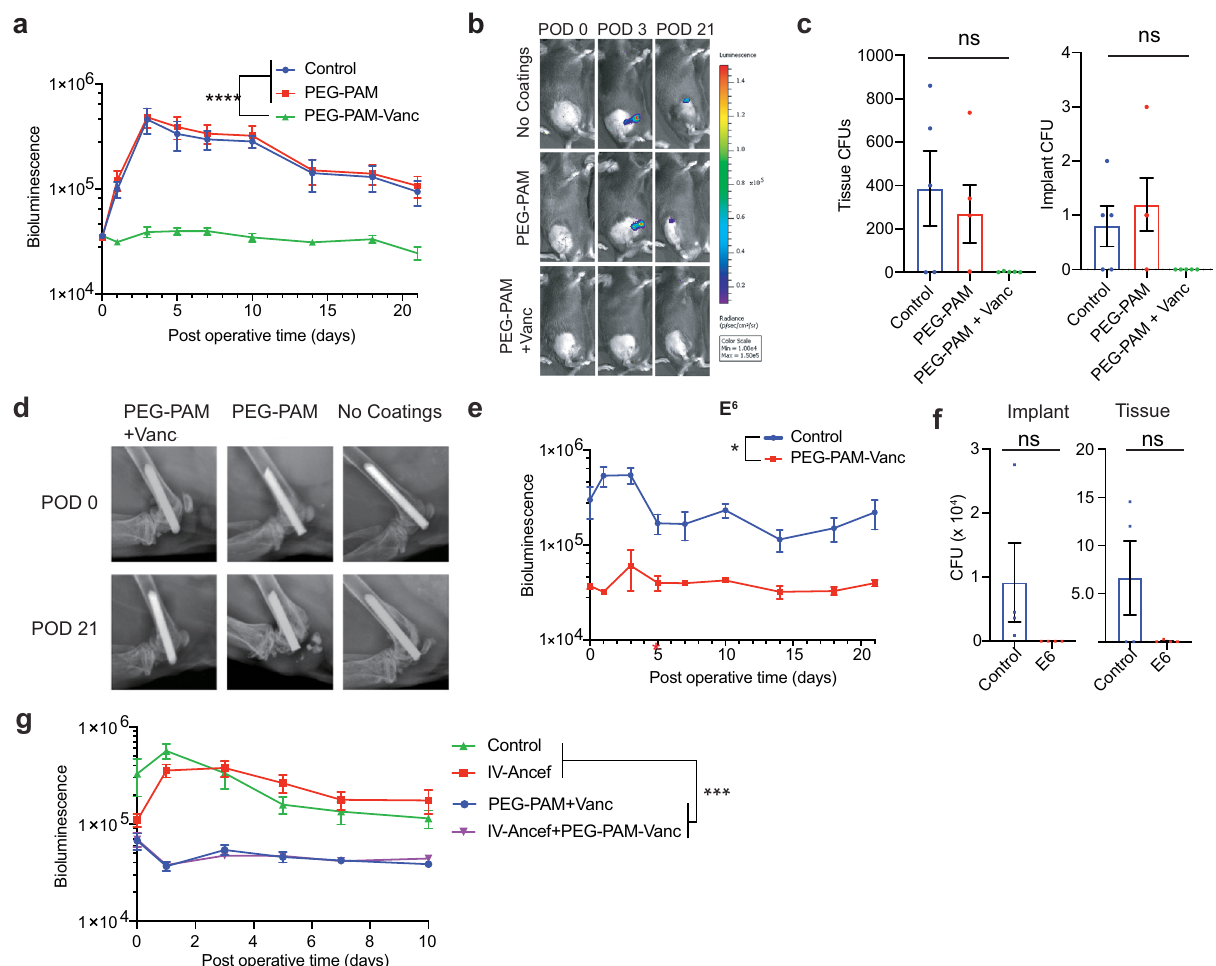
Fig. 5 PEG-PAM coatings loaded with vancomycin prevent implant infection. a Postoperative in vivo S. aureus bioluminescence signal (mean maximum fl ux [photons/sec/cm 2 /sr] (logarithmic scale, n = 15 for no coatings group, n = 14 for PEG-PAM only group, n = 14 for PEG-PAM-Vanc group). b Representative in vivo S. aureus bioluminescence on a color scale overlaid on grayscale images of mice ( c ) Quanti fi cation of colony-forming units (CFUs) cultured from surrounding tissue and implant ( n = 5 for no coating group, PEG-PAM group, and PEG-PAM + Vanc group). d Representative radiographs from the no coatings, PEG-PAM, PEG-PAM + Vanc groups of POD 0 and 21. e Postoperative in vivo S. aureus bioluminescence signals with 1.0×10 6 CFUs loadings of bacterial challenge with PEG-PAM/Vanc coating, n = 4 for the control group, n = 6 for PEG-PAM/Vanc group for the bioluminescence measurement, n = 4 for the control group, n = 4 for PEG-PAM/Vanc group in 1.0×10 6 loading group in CFU counting experiment. f Postoperative in vivo S. aureus bioluminescence signal comparison of PEG-PAM/Vanc coating, IV injection/ancef, IV injection/ancef with PEG-PAM/Vanc and control groups. ( n = 8 for control group, n = 6 for PEG- PAM/Vanc group, n = 6 for IV-ancef group, n = 6 for IV-ancef + PEG-PAM/Vanc group). Statistics in ( a , e , and f ) are a two-way-repeated measure-ANOVA with multiple comparisons post-test. The signi fi cance between treatment groups was **** p <0.0001 For ( a ), was *** p = 0.003 for ( e ), and *** p = 0.0004 for ( g ). Statistics in ( c and f ) are not signi fi cant using an ordinary one-way ANOVA and t -test respectively. Data is plotted showing the Mean and Standard Deviation for bar plots and Standard Error of the Mean for time longitudinal